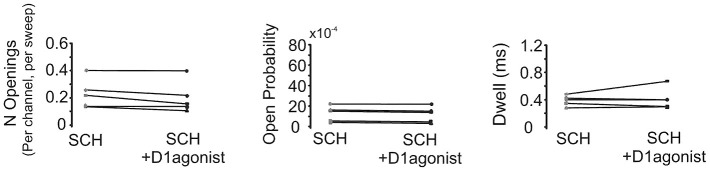
The D1/D5 receptor antagonist blocks the effect of the D1/D5 agonist on the late Na+ channel openings. Quantification of the effects of the D1/D5 agonist (3 µM SKF81297) in the presence of the D1/D5 receptor antagonist (3 µM SCH23390) on the average number of late openings (per channel, per sweep) (left), the open probability (middle) and the average dwell time (right) of single Na+ channels recorded from the PD during a 70 mV depolarizing step. Patches were held 20 mV more negative than resting membrane potential. Each pair of connected dots represents data from the same patch.